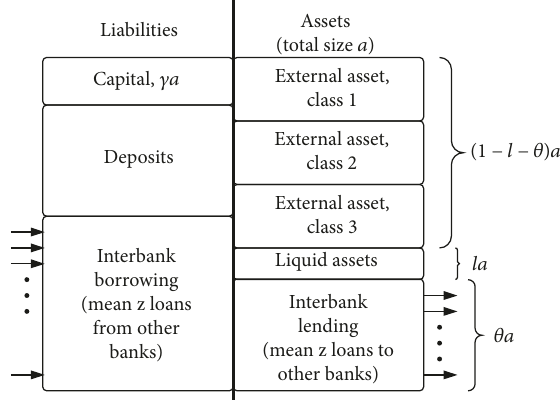
Figure 2: A balance sheet representation of a bank (adapted from [6]). a =total assets; γ =capital ratio; l =liquidity ratio; θ = interbank loans-to-assets ratio; z =average number of incoming and outgoing